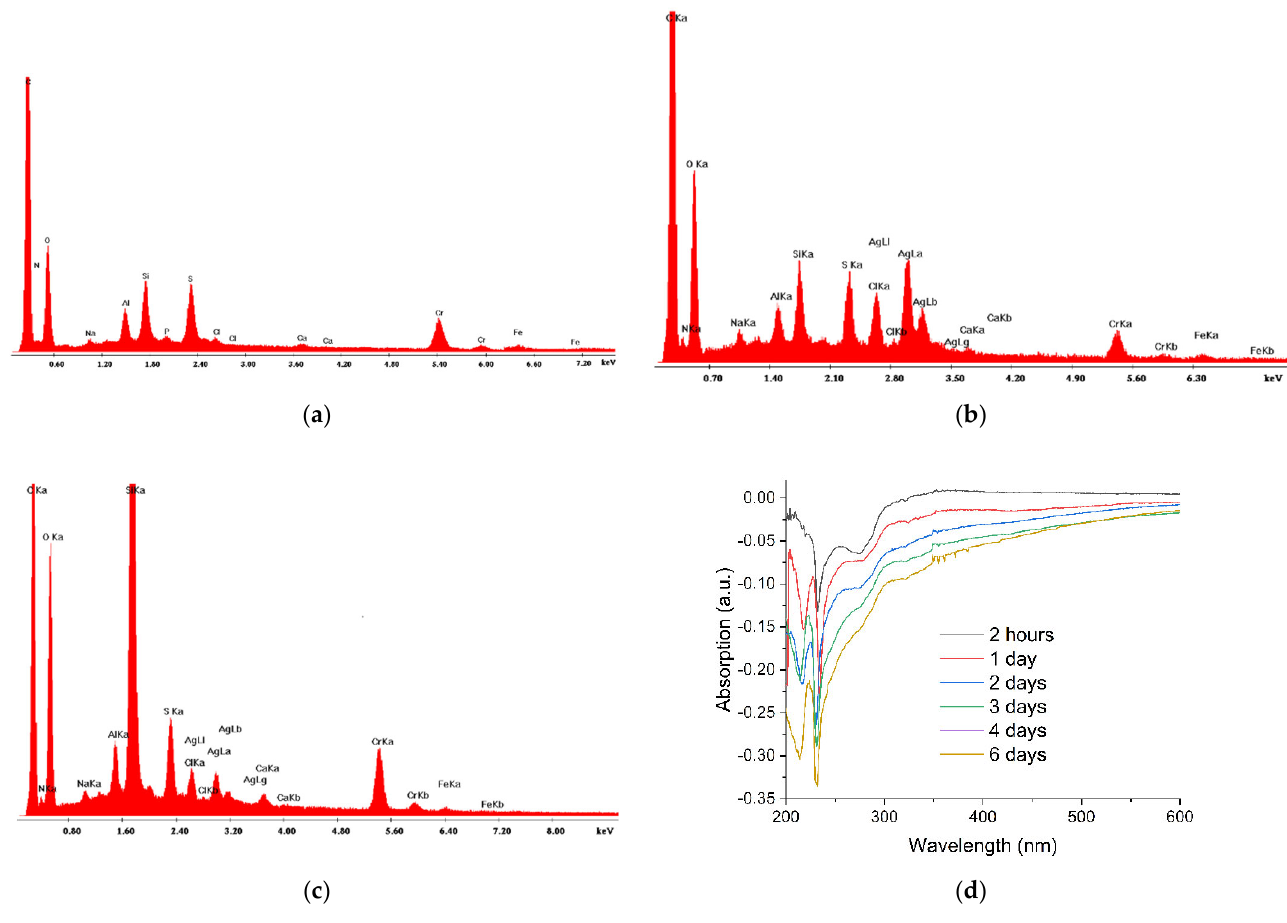
Figure 5. Energy ‐ dispersive X ‐ ray spectra of: ( a ) untreated leather; ( b ) leather wetted with PEI ‐ Ag Nps; ( c ) leather coated by silica ‐ PEI ‐ Ag Nps composite xerogel; ( d ) UV ‐ Vis spectra of the supernatant solutions of leathers coated with composite xerogels at different time intervals. The respective supernatants of untreated leathers are used as controls.